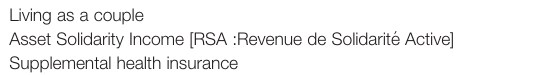
TABLE 2 | Description of binary socioeconomic factors. Living as a couple 50.2% Asset Solidarity Income [RSA :Revenue de Solidarite ́